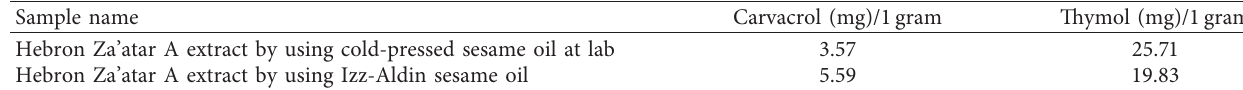
Table 3: Carvacrol and thymol content by using regular and cold-pressed sesame oil.